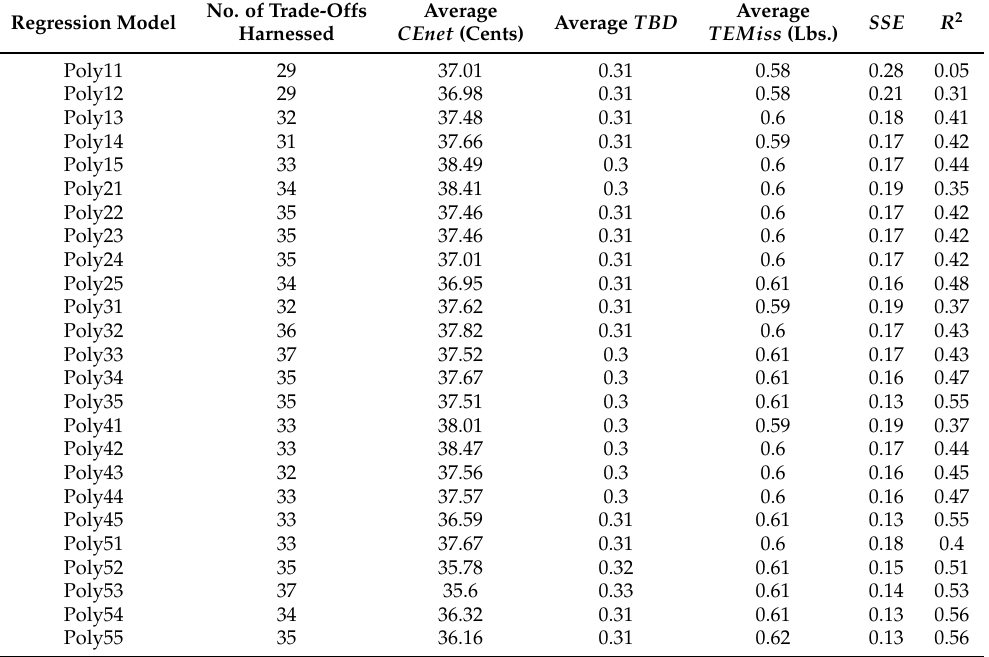
Table 12. A comparison of performance parameters for polynomial based